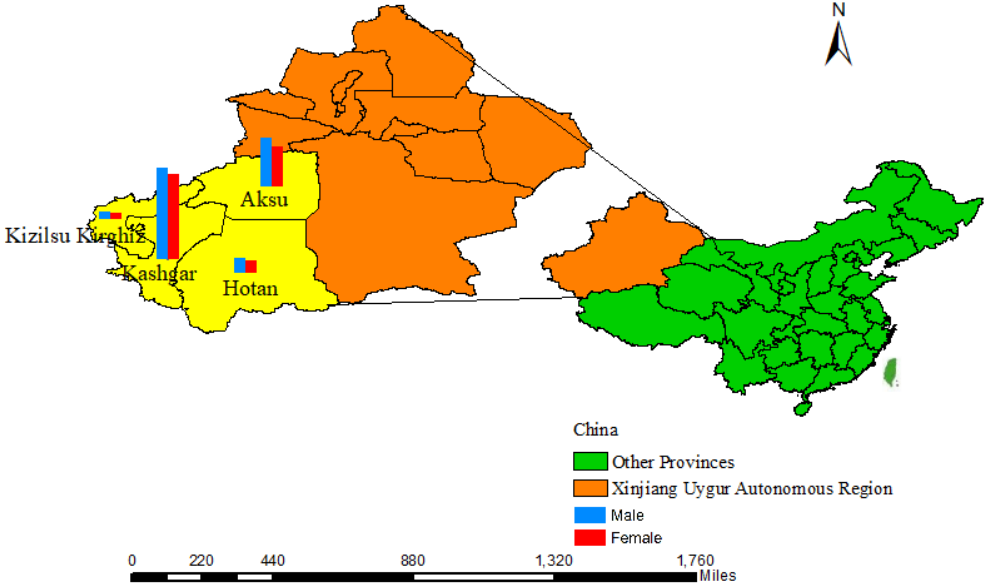
Figure 1. The specific geography location of four prefectures in southern